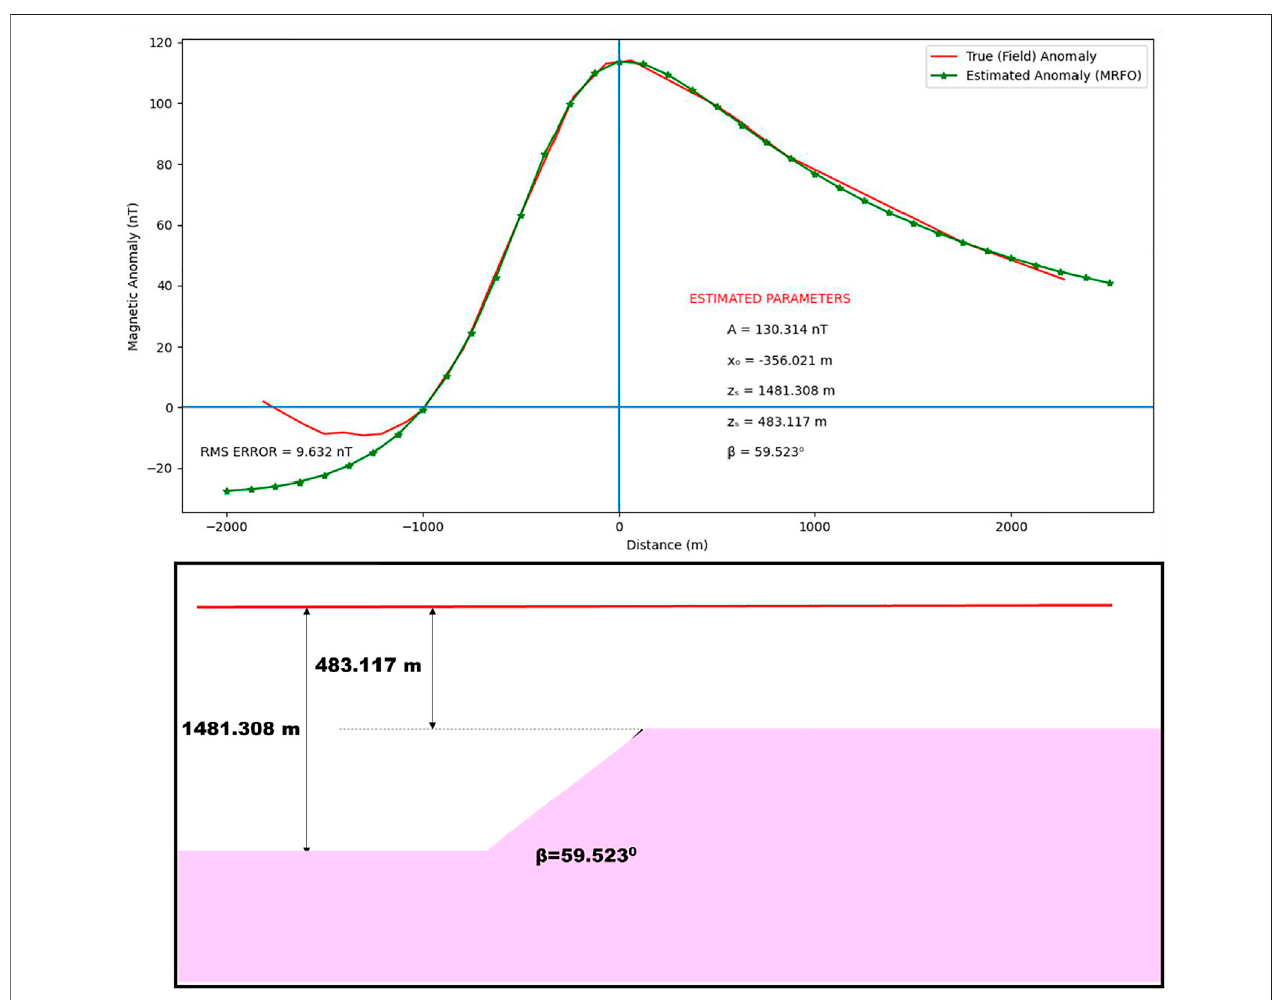
FIGURE 8 | Total magnetic anomaly of Lanchlan anomaly, Australia inverted using the MRFO procedure.